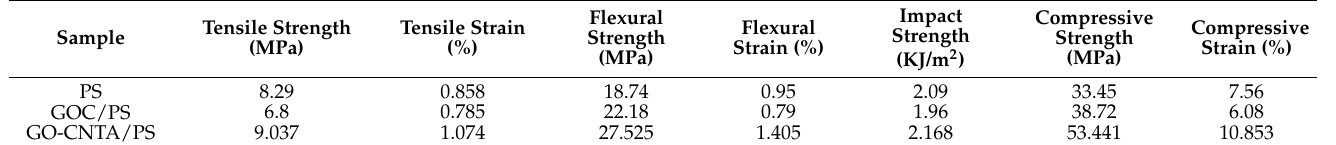
Table 2. Mechanical properties of different composites.